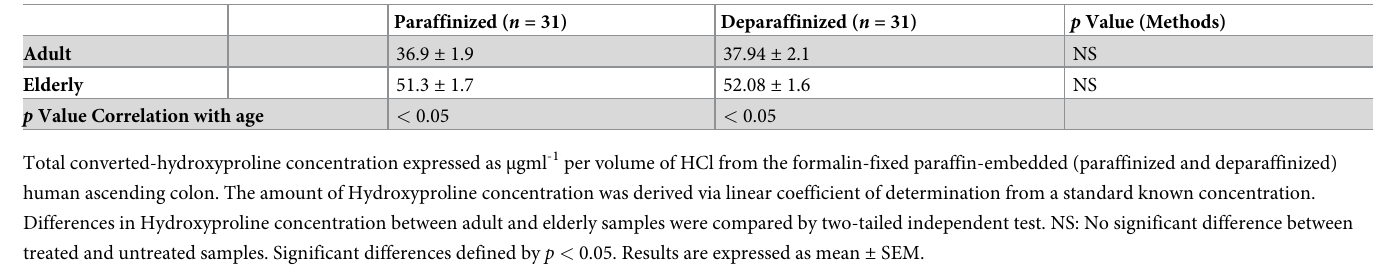
black and white using ImageJ processing. Scale bars represent 60 μ m. Box plots show the positive pixel of collagen content ± SEM ( n = 22 patients) distributed within the mucosa, submucosa and muscularis externa between the adult and the elderly as measured by ImageJ. Each ROI were selected with a tracing tool and positive pixel values obtained from binarised image per the selected layer. All data were obtained from a mean of each ROI. Total collagen content between adult and the elderly per each ROI were compared by a two-tailed independent student’s t-test. Statistical significance is: � P < 0.05.